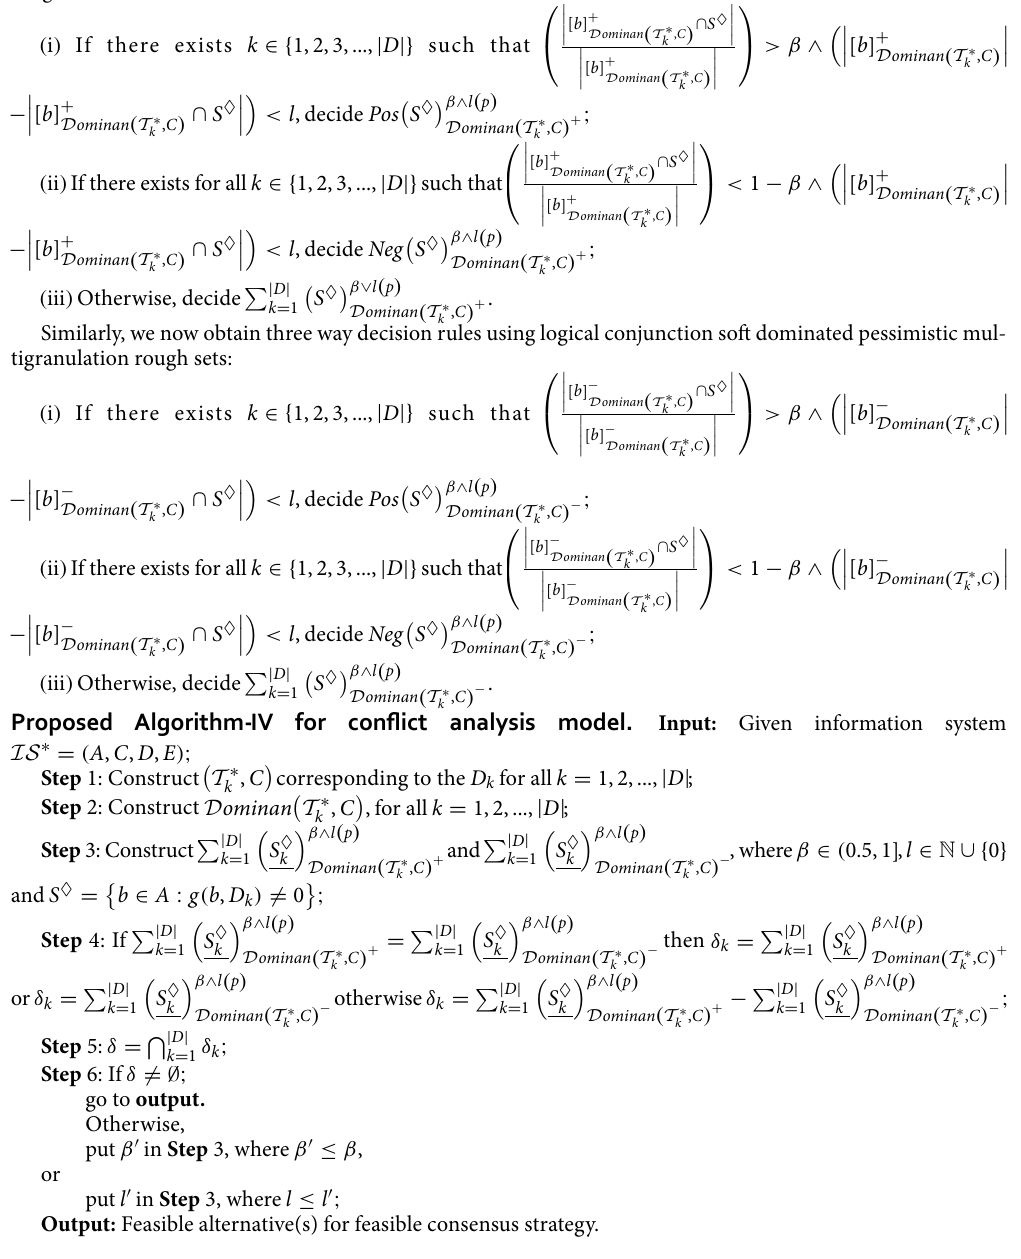
(i) The proposed model focusses on combining variable precision rough set model with graded rough set model by using logical operators in multigranulation approximate space. Further the proposed multi- granulation rough set model which considers the relative and absolute quantitative information about the degree of overlapping between soft dominance classes and a concept set. (ii) The proposed model answer questions posed by